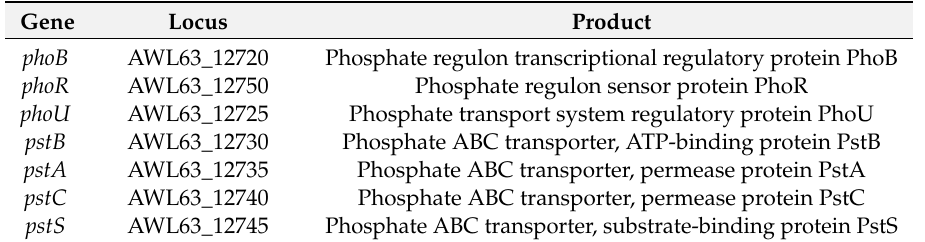
Table 1. Phosphate metabolism of S. panacis DCY99 T .